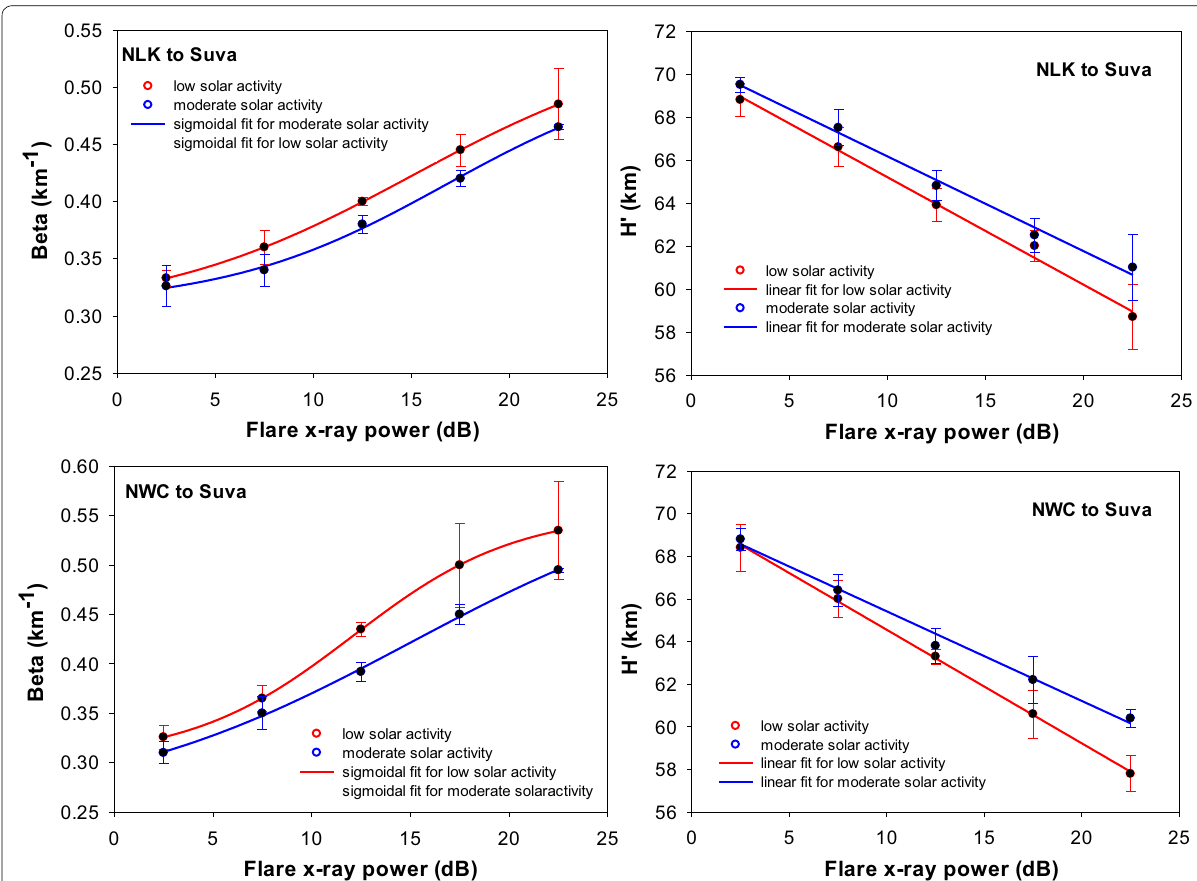
Fig. 9 Ionospheric D-region parameters H ′ and β , determined as functions of solar X-ray flare power from the mean VLF amplitude and phase per- turbations of selected flare power bins of Fig. 8 during the low- and moderate-solar activity periods. The points plotted in red and their best-fit lines correspond to low solar activity, while the points plotted in blue and their best-fit lines correspond to moderate-solar activity